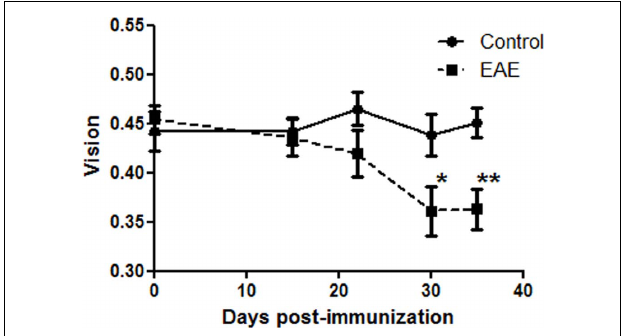
FIGURE 5 |Vision decreased in EAE mice by 30days post-immunization. OKR responses were recorded in C57/BL6 mice prior to immunization (time 0).Vision is reported as the threshold cycles/degree tracked on a rotating cylinder. EAE mice were immunized with MOG, and control mice were sham injected with PBS, on day 0, and OKR responses were recorded 15, 22, 30, and 35days later. OKR responses were significantly reduced in EAE eyes as compared to control eyes at day 30 (* p = 0.05) and day 35 (** p = 0.019)